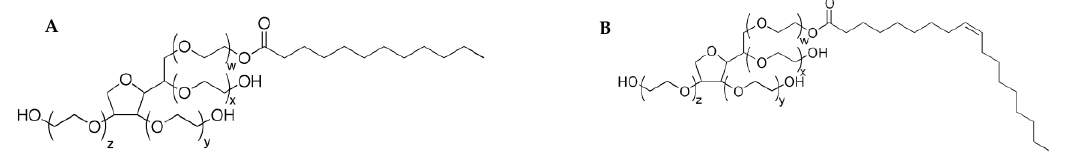
Figure 6. Chemical structure of Tween 20 ( A ) and Tween 80 ( B ).